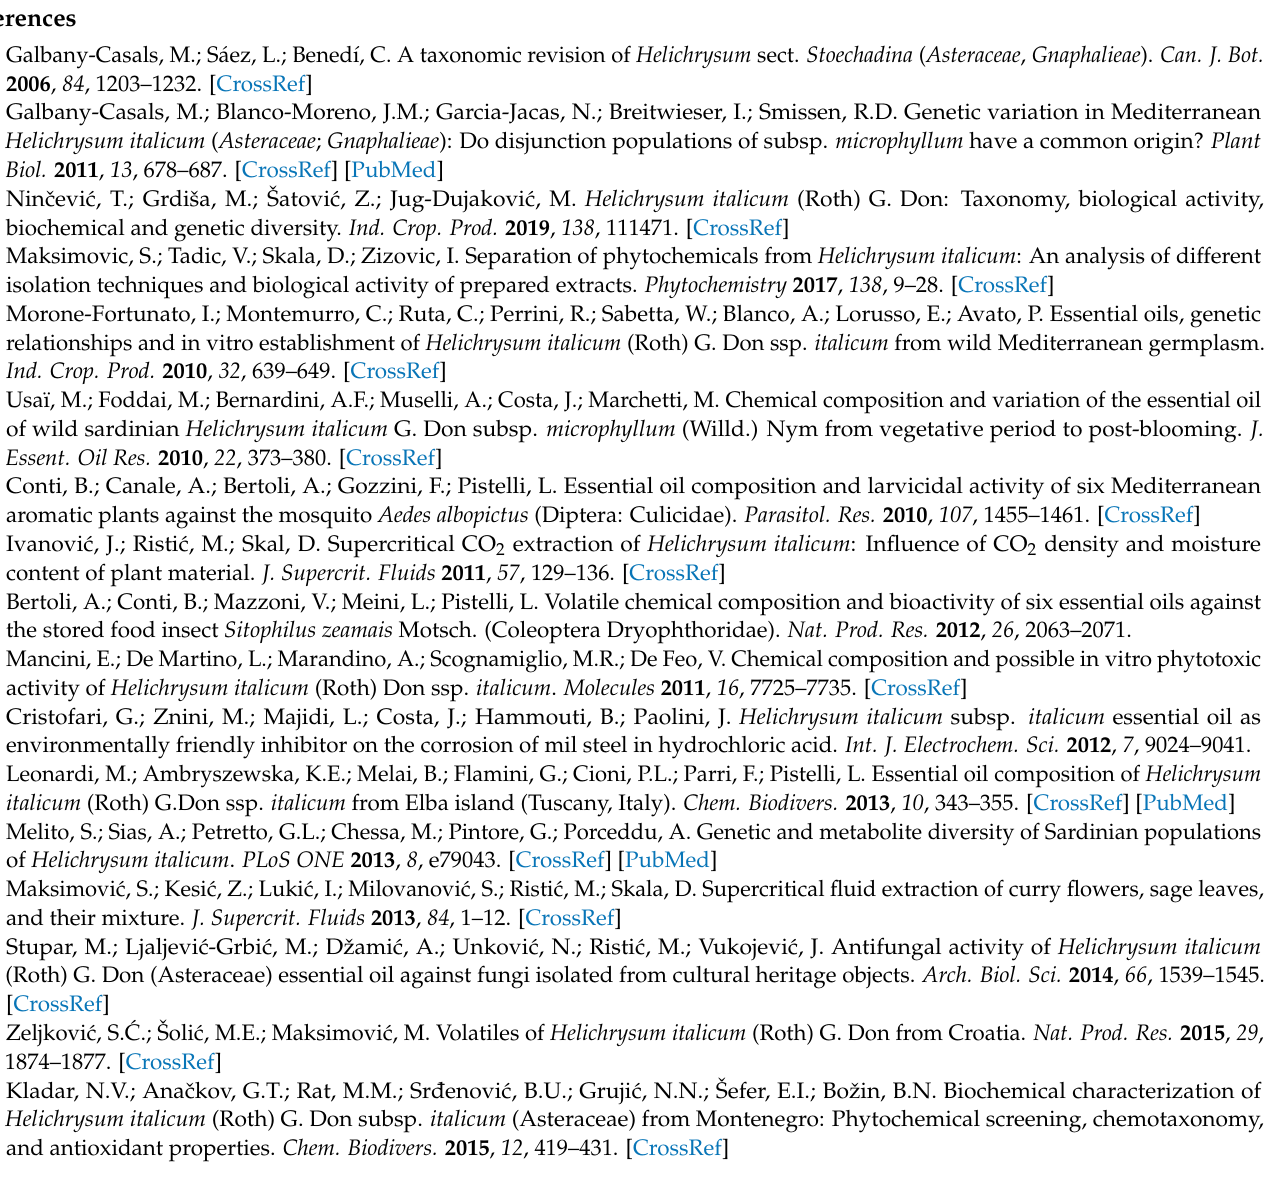
assay, Figure S4. Dependence of brine shrimp ( Artemia salina ) larvae lethality (%) on Log of essential oil concentration in saline